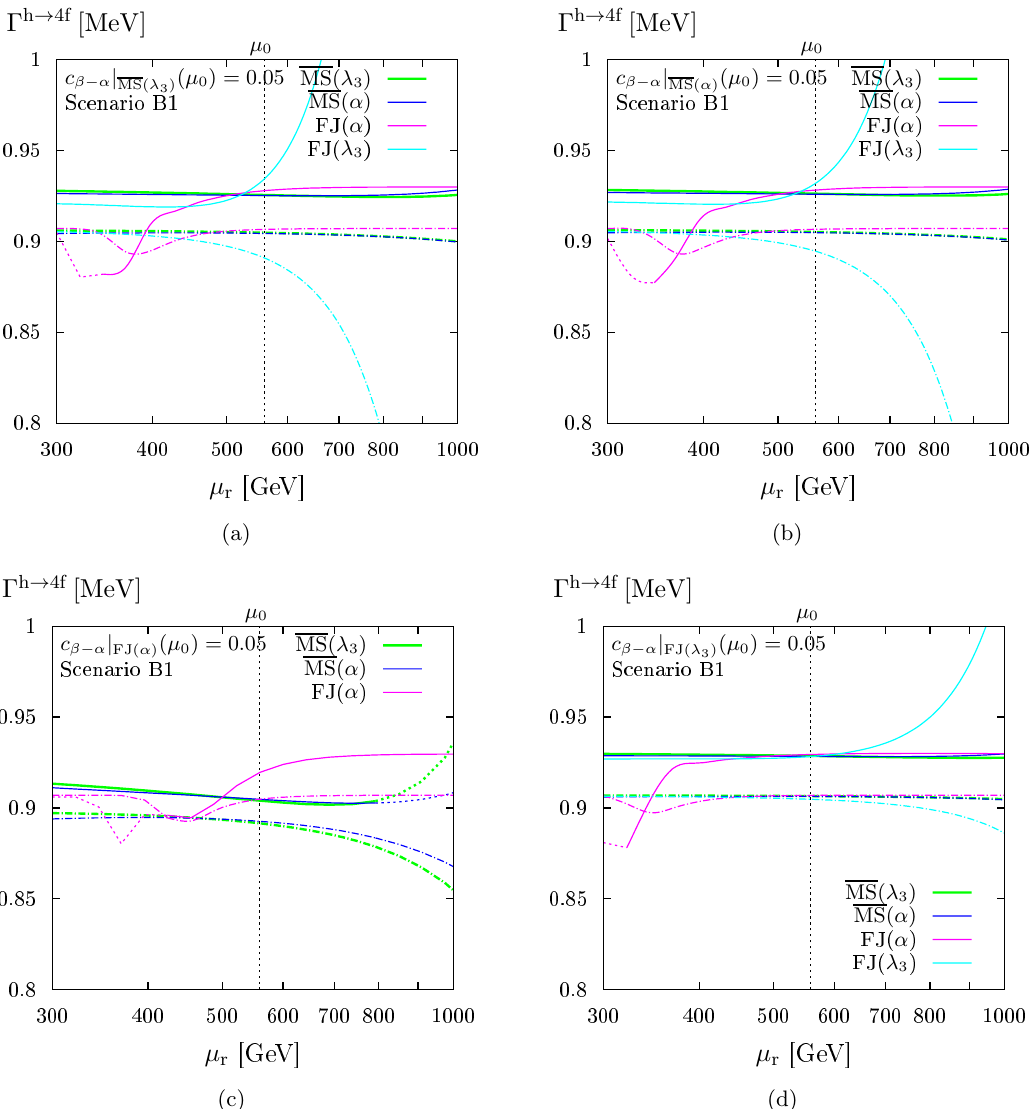
Figure 34 . As in (cid:12)gure 23, but for scenario B1 with c (cid:12) (cid:0) (cid:11) = 0 : 05.